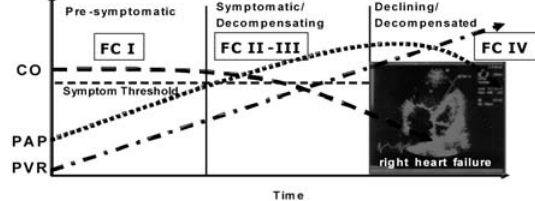
Figure 1 Matching of haemodynamic (cardiac output, CO, mean pulmonary arterial pressure, PAP, and pulmonary vascular resistances, PVR) and clinical (functional NYHA classes, FC) deterioration in untreated arterial pulmonary